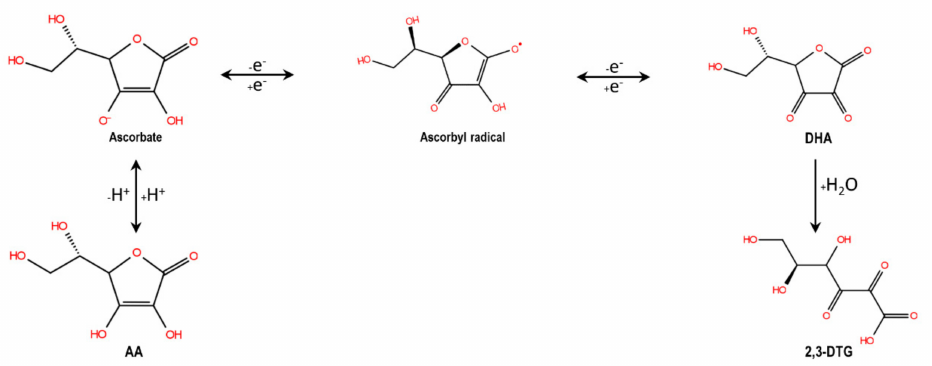
Figure 1. Degradation of ascorbic acid (AA) to dehydroascorbic acid (DHA) and 2,3-diketogulonic acid (2,3-DTG) by UV irradiation by photooxidation and subsequent